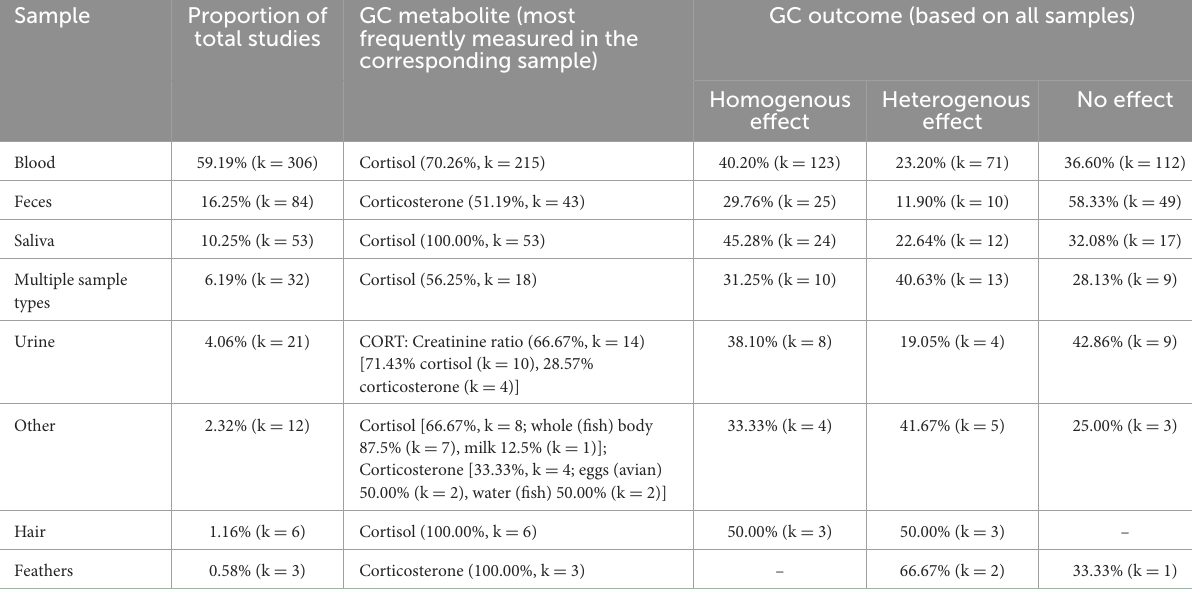
TABLE 3 Ranking of the proportion and total numbers of experiments (517 experiments in 509 studies) of biological sample types used for determination of GC levels, the corresponding most commonly determined GC metabolite and the outcome of the GC